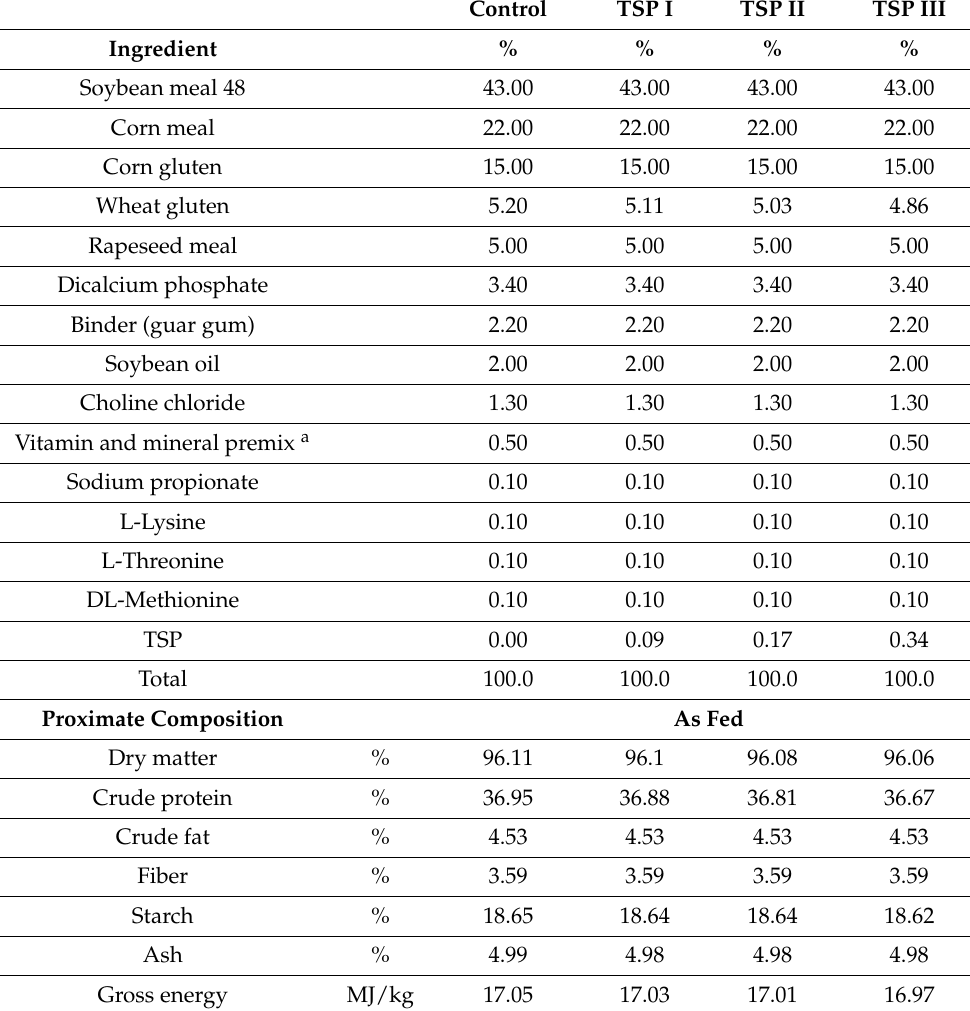
Table 1. Formulations and proximate compositions of the experimental diets (AOAC,